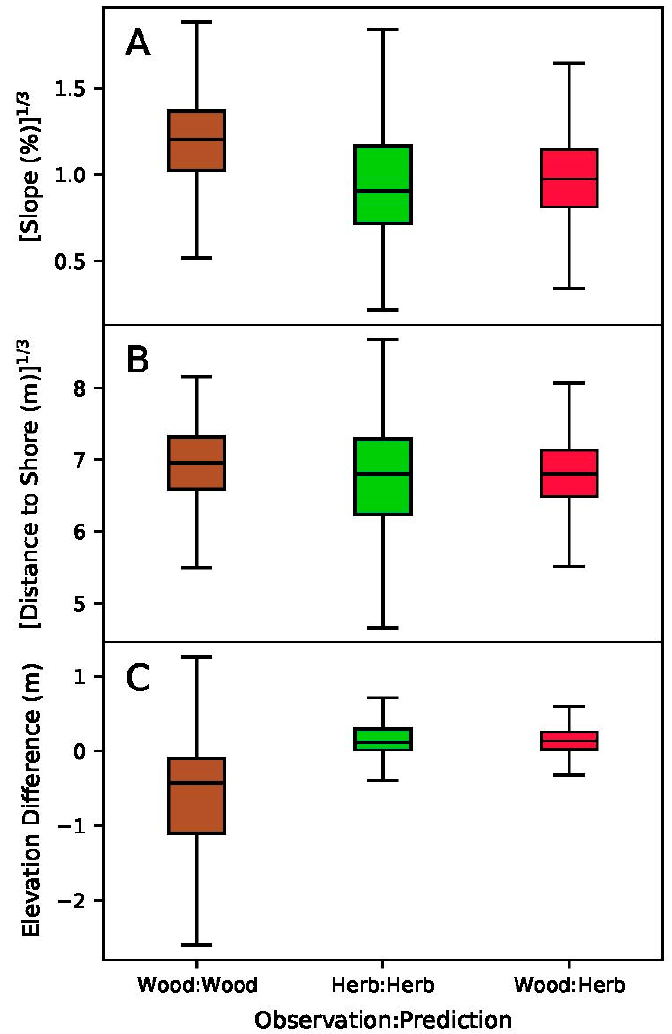
Figure 6. Box plots of ( A ) transformed slope, ( B ) transformed distance to shore, and ( C ) elevation difference of correctly identified woody habitats (left), correctly identified herbaceous habitats (center), and woody habitats that were incorrectly identified as herbaceous habitats (right).